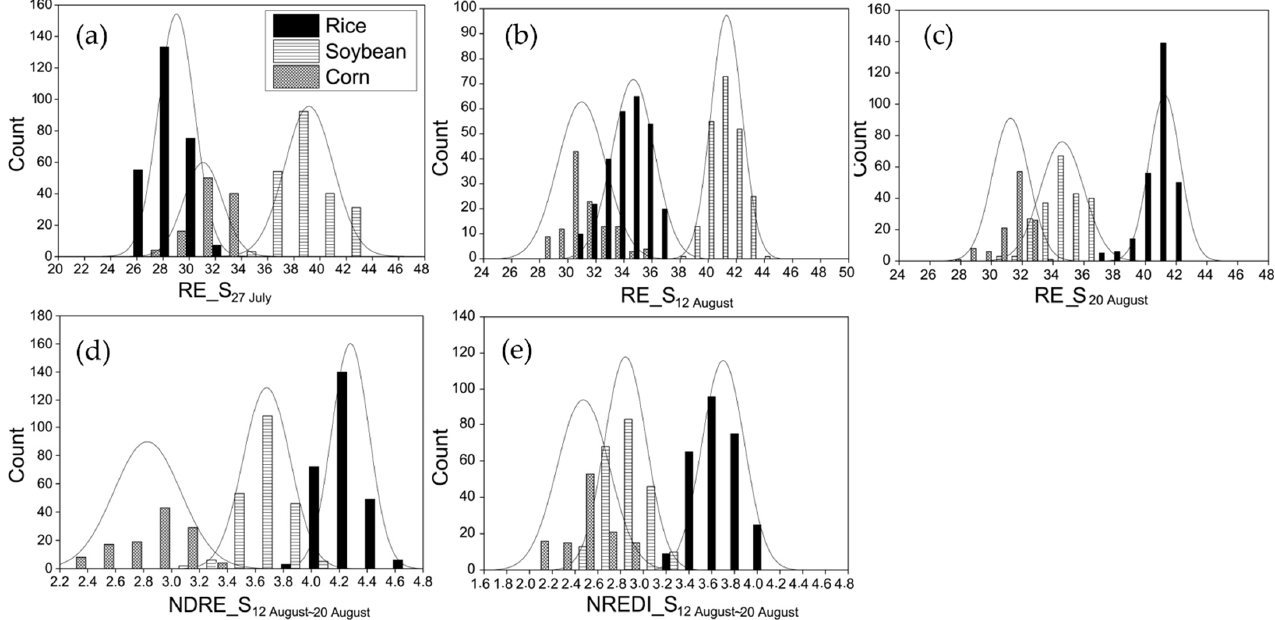
Figure 8. Threshold histogram of integral value from red-edge band to near-infrared band on ( a ) 27 July 2019; ( b ) 12 August 2019; ( c ) 20 August 2019; and the integral value of red-edge vegetation index based on time series ( d ) NDRE_S 12 August~20 August ( e ) NDREI_S 12 August~20 August for three croplands.